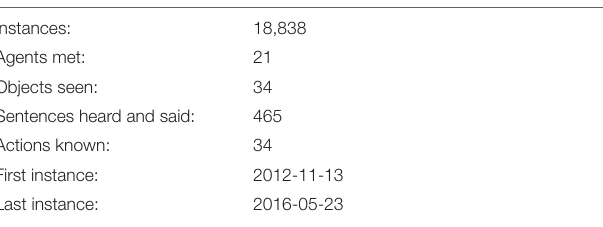
TABLE 4 | Summary statistics on data contained in the episodic memory of the